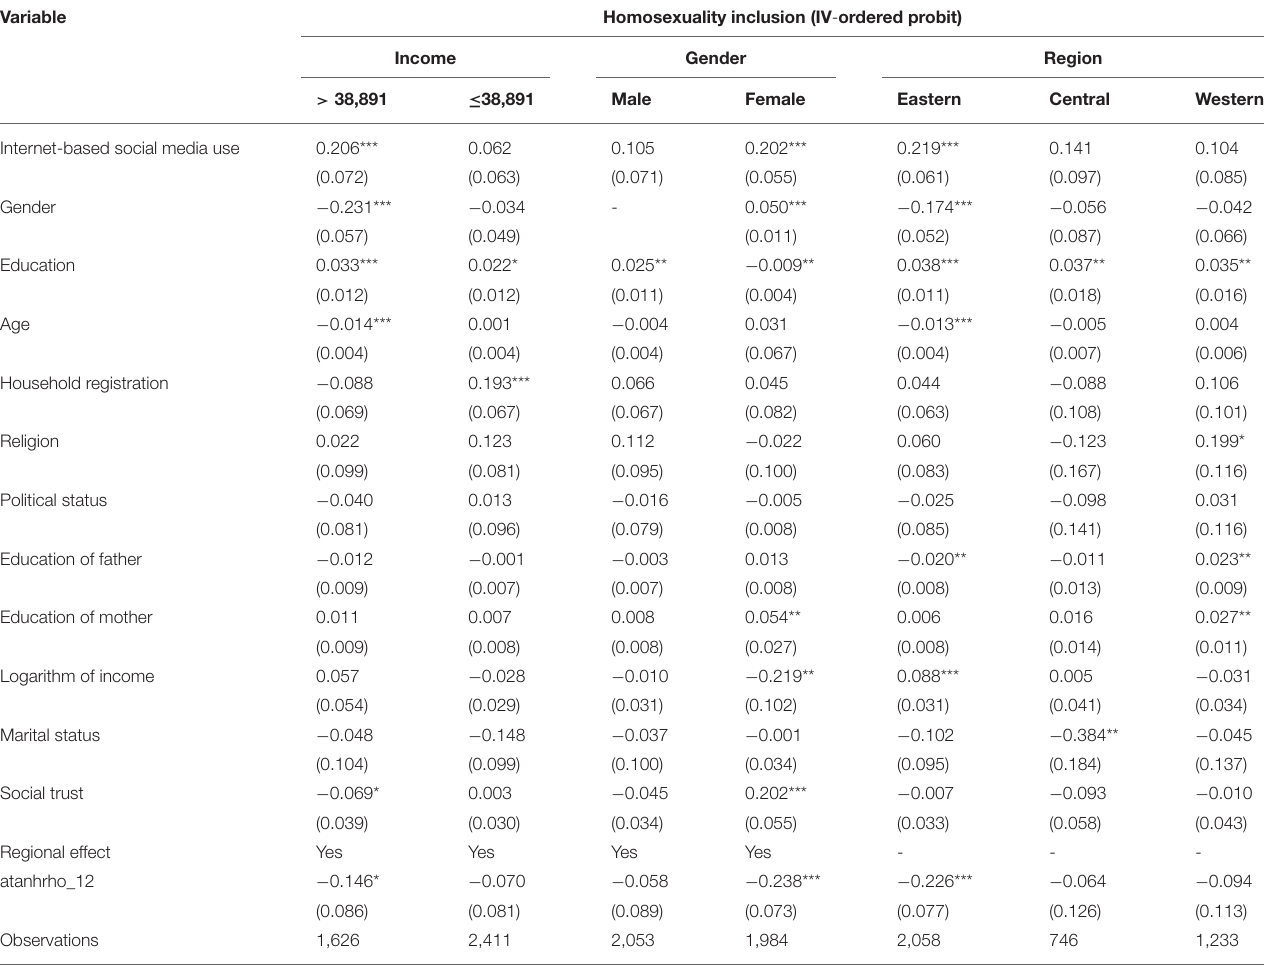
TABLE 3 | Heterogeneous effect of internet-based social media use on homosexuality inclusion.